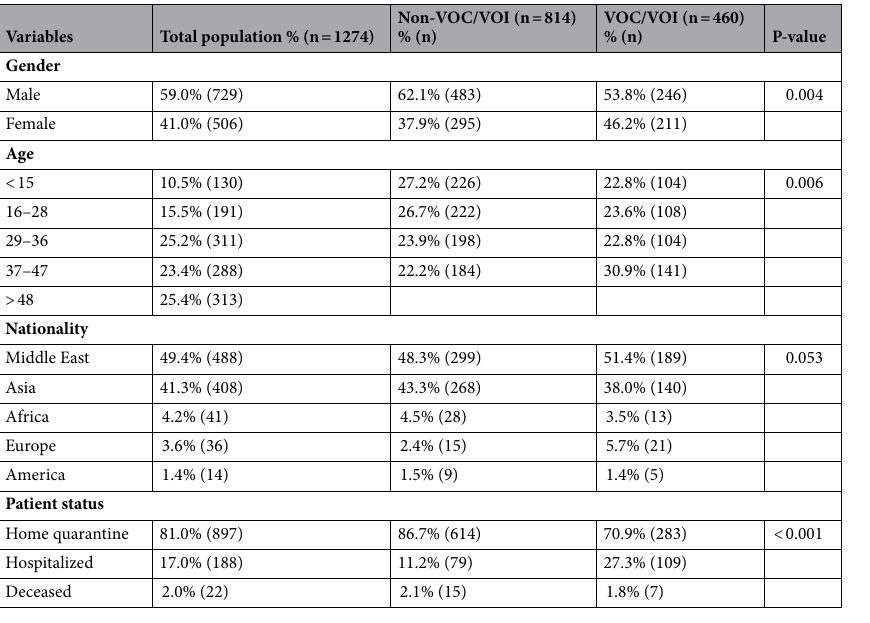
Table 1. Demographic of COVID-19 cases (n = 1274), stratified by VOC /VOI